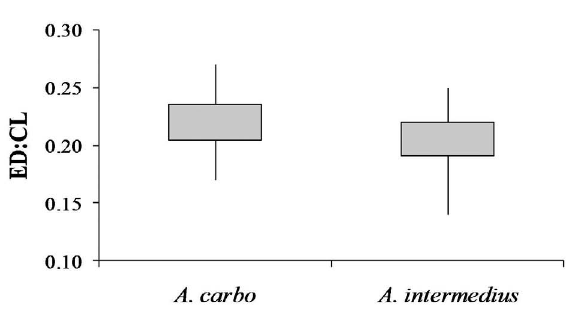
Fig. 5 . – Power relationships between otolith weight and otolith length and height in A. carbo (black dots) and A. intermedius (white